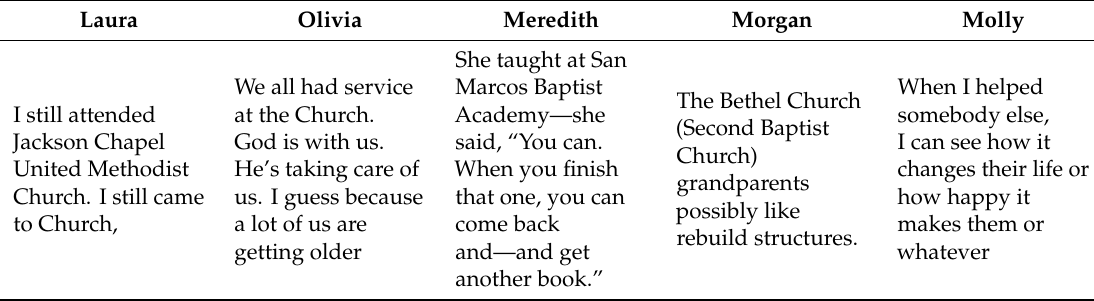
Table 4. Emergent Themes for Faith and Sense of